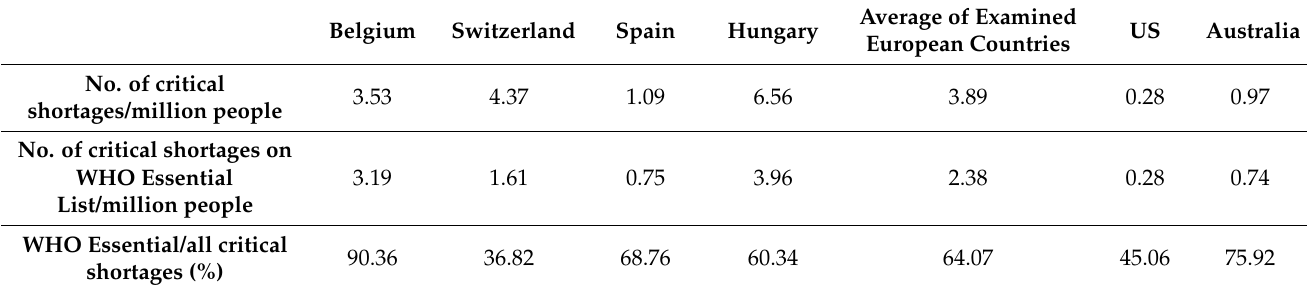
Table 5. Summary of critical shortages of the examined countries according to the WHO Essential Medicine